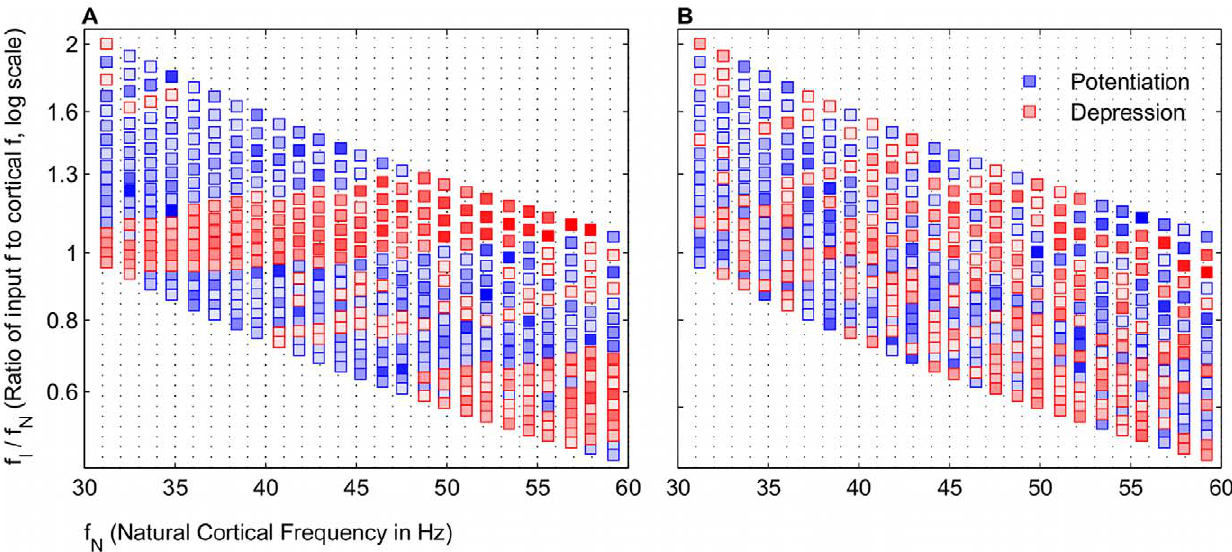
Figure 3. Frequency map structure requires gamma frequency input. Frequency ratio is plot as a function of f N . (A) Map is a subset of Fig. 3, shown for comparison with (B). With a gamma frequency input, broad bands of potentiation and depression are distinct. (B) With a Poisson distributed stochastic input, potentiation still occurs but not in regular bands.